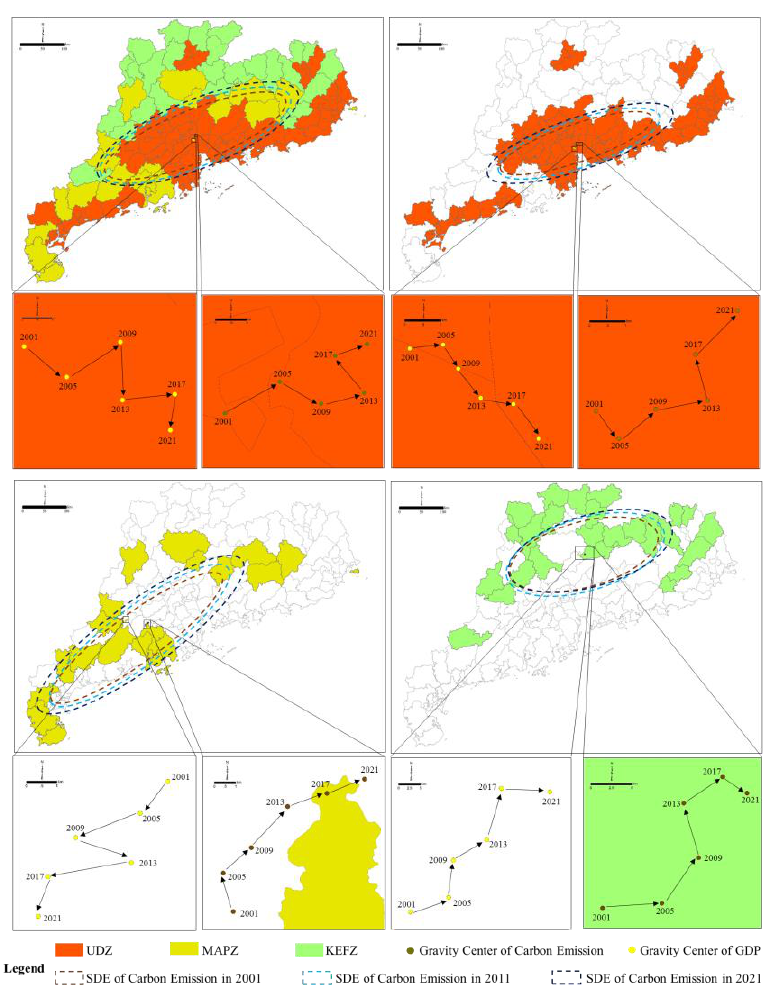
Figure 8. Migration of GDP, carbon emission (CE) gravity center, and changes in the standard deviation ellipse (SDE) in Guangdong Province and its MFOZs.